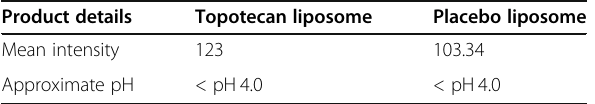
Table 9 Summary of AFM analysis of topotecan liposome